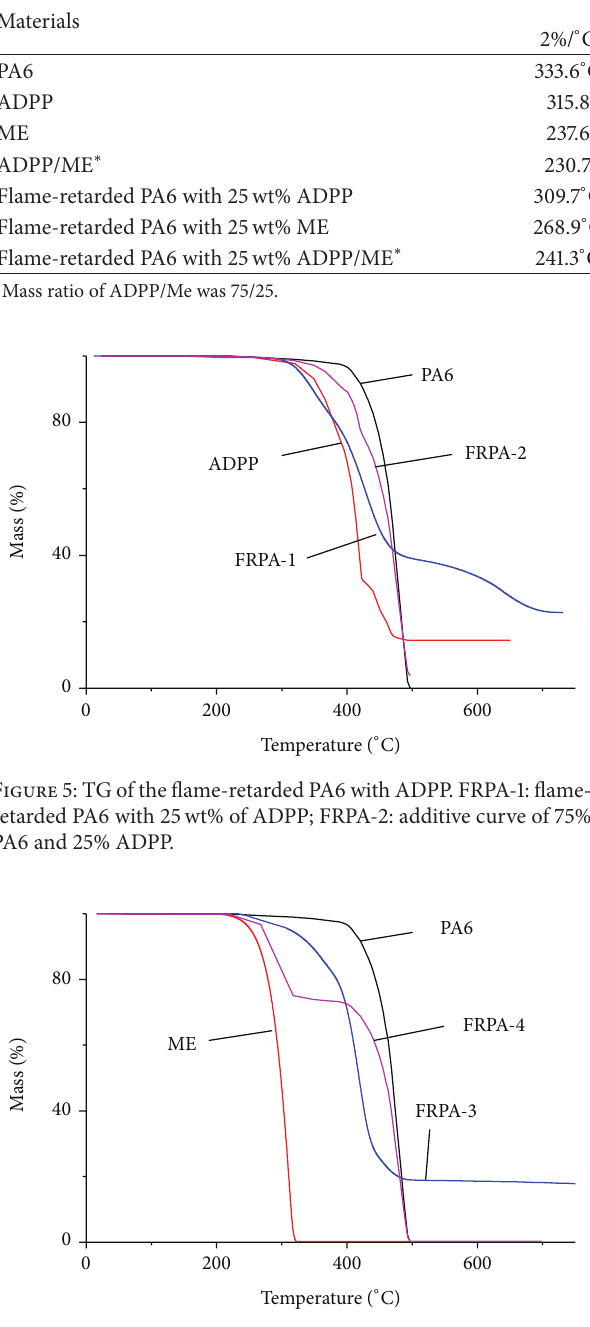
Figure 6: TG of the flame-retarded PA6 with ME. FRPA-3: flame- retardedPA6with25 wt%ofME;FRPA-4:additivecurveof75%PA6 and 25%